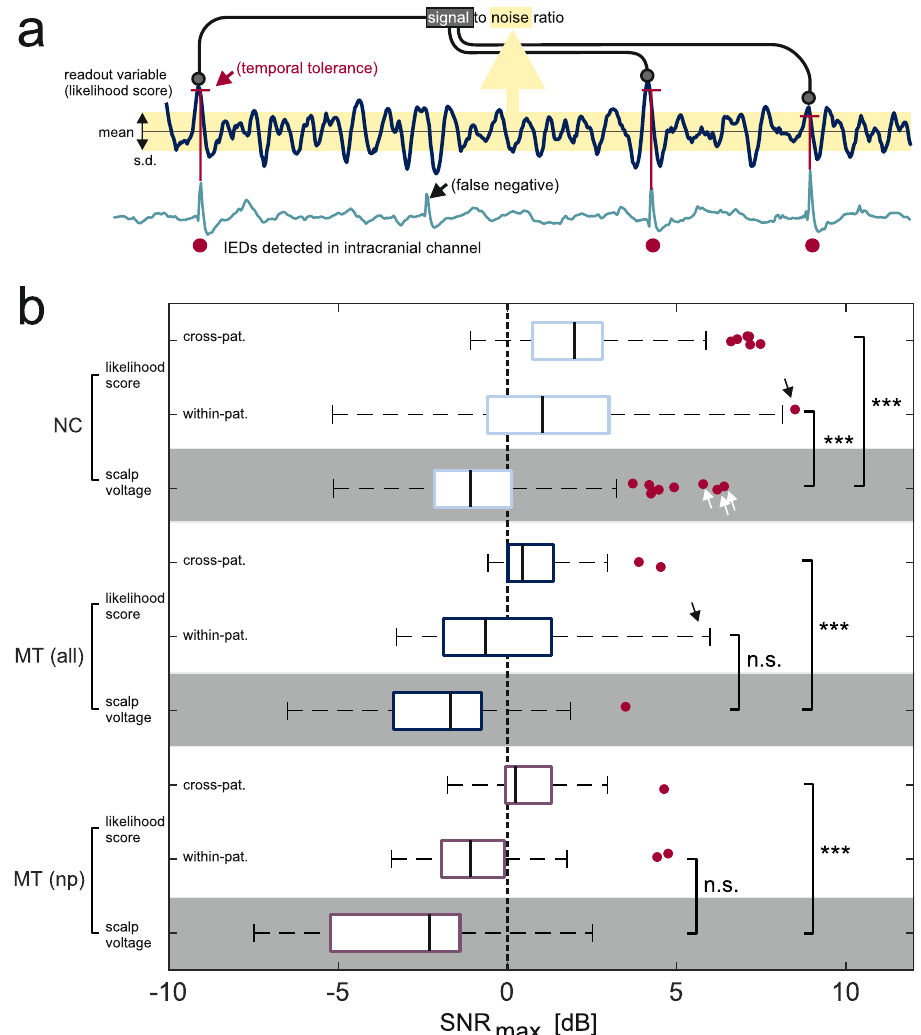
Figure 5. Signal-to-noise ratio assessment. ( a ) Analysis of SNR based on intracranially detected IEDs (red dots). A false negative case of automatic intracranial IED detection is illustrated. ( b ) SNR max was higher for likelihood-scores (white background) than for scalp voltage-based (gray background) detection of all IED categories (NC, MT, and MT-np). Detection using cross-patient template-queried channel combinations was more effective than using within-patient combinations (in which case performance was also notably more variable, occasionally giving rise to very high SNR, black arrows). Scalp voltage also occasionally predicted intracranial NC IEDs with high SNR (white arrows) when the scalp IED expression was particularly strong. NC neocortical, MT mesial-temporal, np